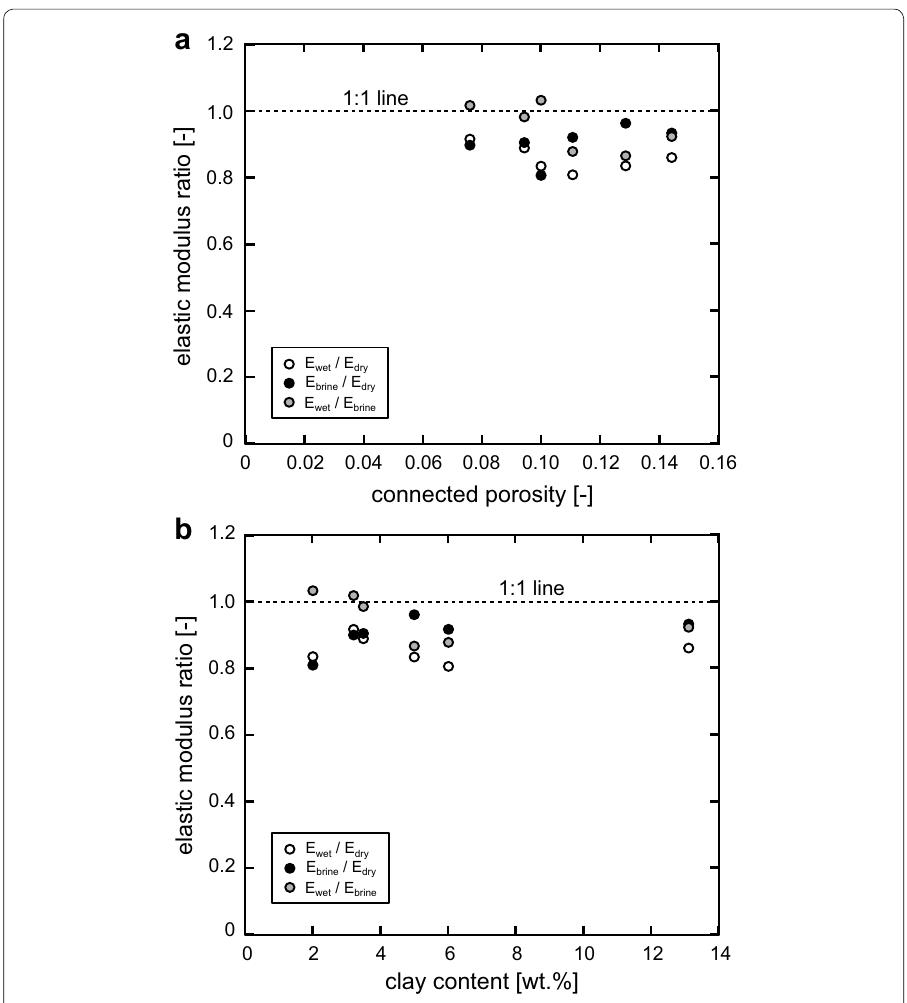
Fig. 8 a Ratios of water-saturated-to-dry elastic modulus, brine-saturated-to-dry elastic modulus, and wat er-saturated-to-brine-saturated elastic modulus for the six sandstones sampled from exploration well EPS-1 at Soultz-sous-Forêts (France) as a function of connected porosity. b Ratios of water-saturated-to-dry elastic modulus, brine-saturated-to-dry elastic modulus, and water-saturated-to-brine-saturated elastic modulus for the six sandstones sampled from exploration well EPS-1 at Soultz-sous-Forêts as a function of clay content (clay content is the wt% of muscovite/illite–smectite; Table